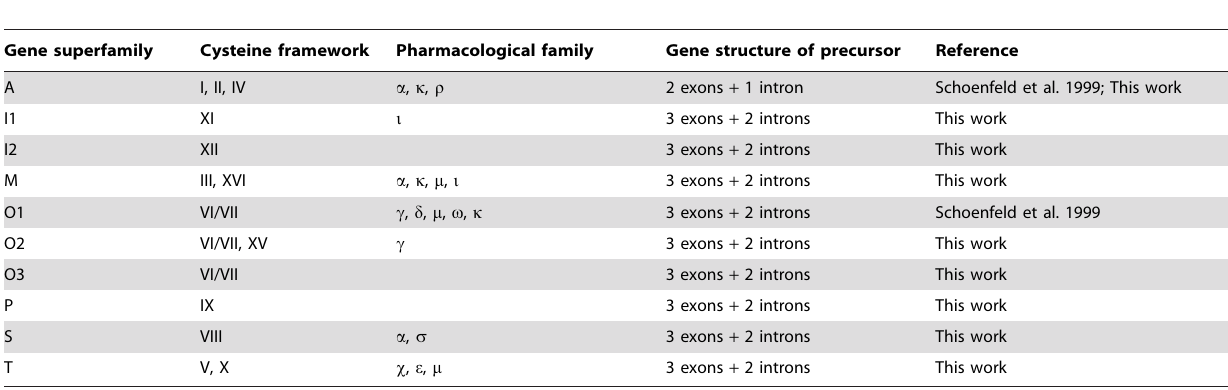
Table 2. The relationships among conotoxin gene structure, gene superfamily, cysteine framework and pharmacological family. The correlations among the classification schemes have also been showed by Kaas et al [7].